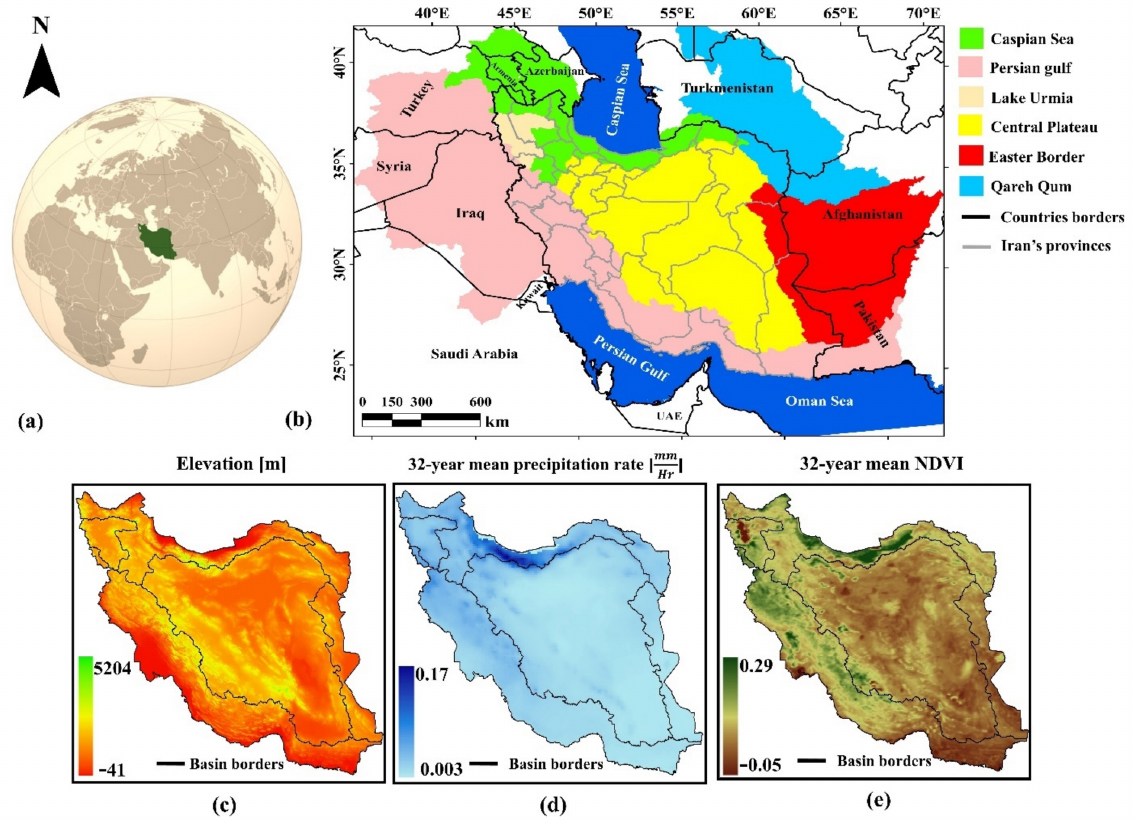
Figure 1. Study Area: ( a ) location of Iran, ( b ) geographical position of Iran’s basins and 31 provinces, ( c ) 90 m DEM (above Geoid), ( d ) 32-year mean precipitation rate (1990–2021), and ( e ) 32-year mean NDVI